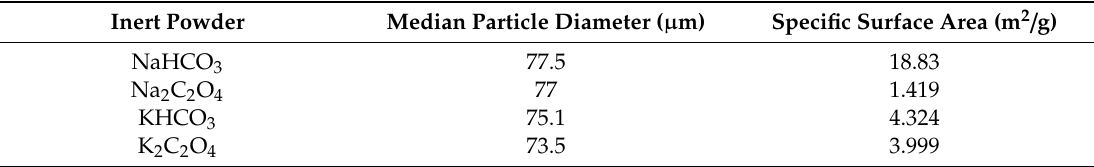
Table 1. Specific surface area of the four inert powders of same particle